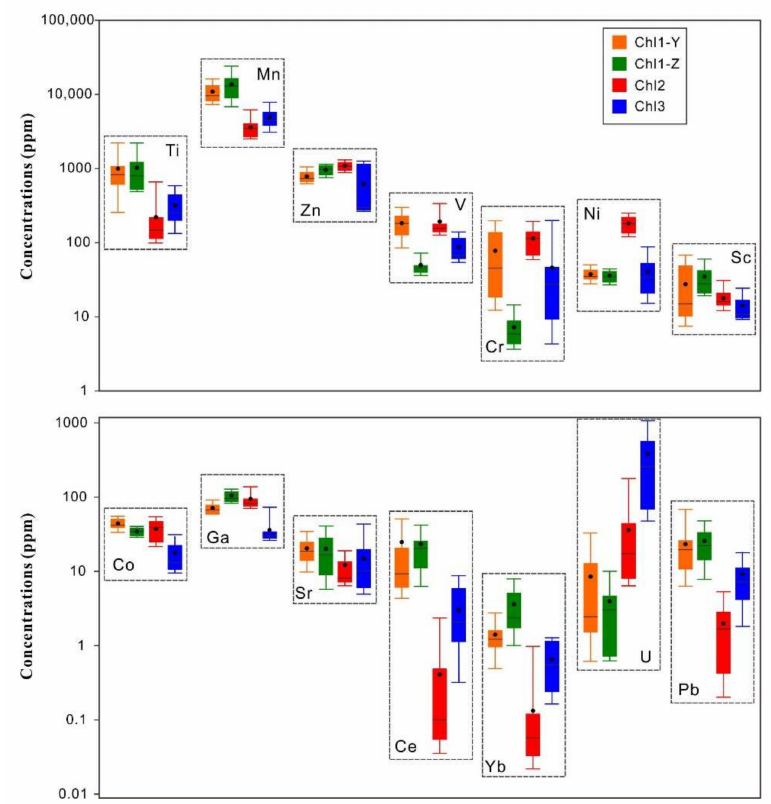
Figure 6. Trace element box plot for chlorite at the Zoujiashan deposit and Yunji